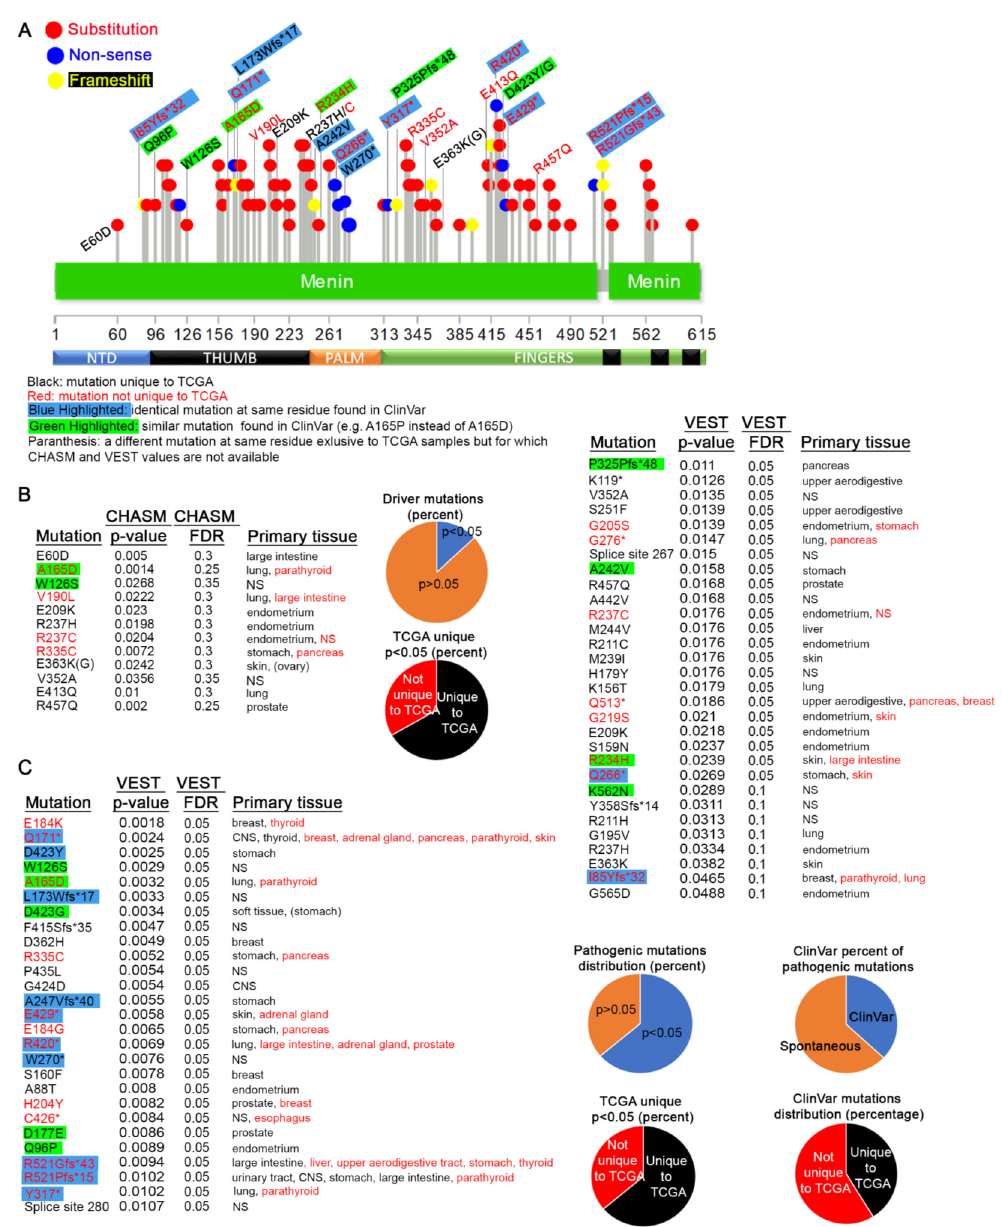
Figure 6. MEN1 mutations in primary cancers. ( A ) Distribution of all germline mutations that appear in TCGA samples of primary cancer sites. The legend explaining the color-coding scheme is shown below the diagram. ClinVar does not give the exact frameshift mutation, but, if a frameshift is indicated at the same residue, we assumed it to be identical. ( B,C ) CHASM, VEST p-values, and tissue distribution for the mutations shown in ( A ). The same color-coding scheme as in ( A ) is observed. Pie charts summarize the data in the tables.